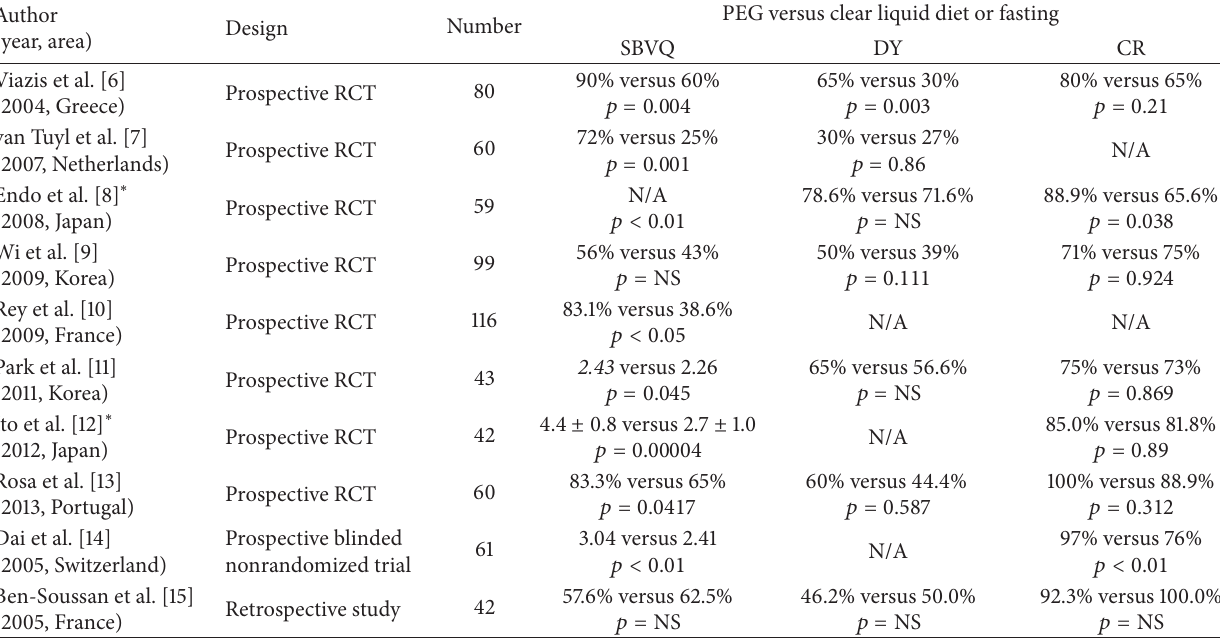
Table 2: Studies comparing SBVQ, DY, and CR between PEG solution versus clear liquid or fasting of small bowel